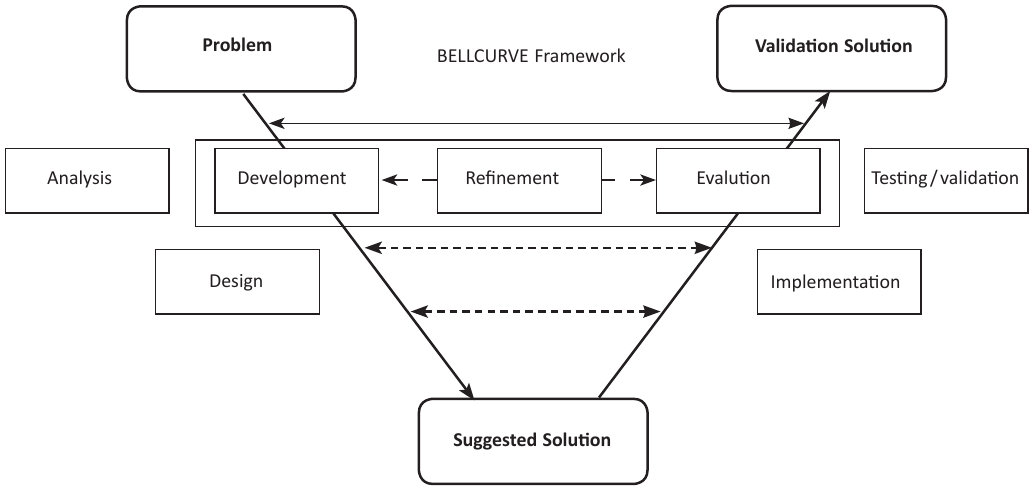
Figure 3. BELLCURVE framework development through a design science approach